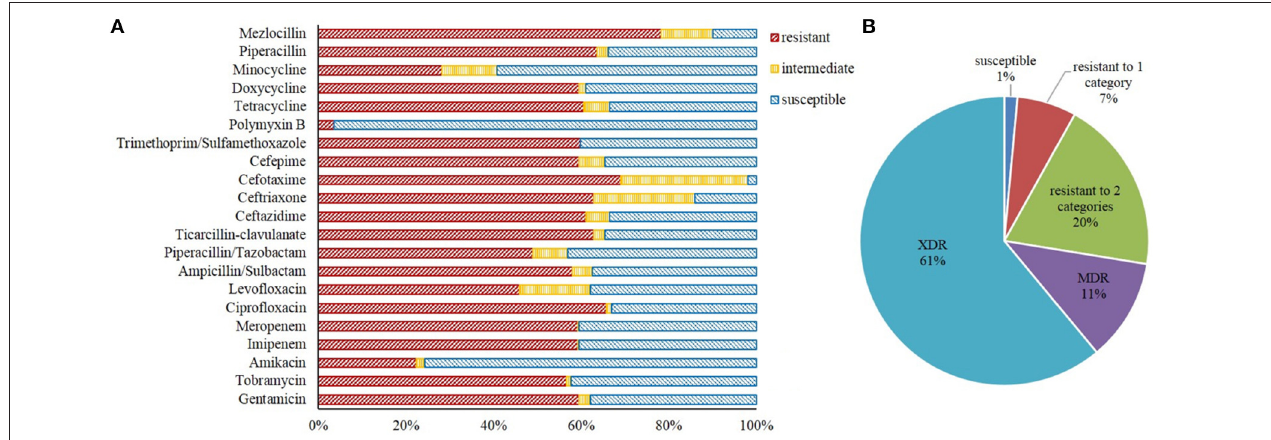
FIGURE 1 | Antibiotic resistance phenotypes of A. baumannii isolates examined in this study. (A) The resistance rate of all strains to 16 of the 21 antibiotics were above 50%. (B) Approximately 72.4% of the isolates exhibited multidrug or extensively drug resistance.